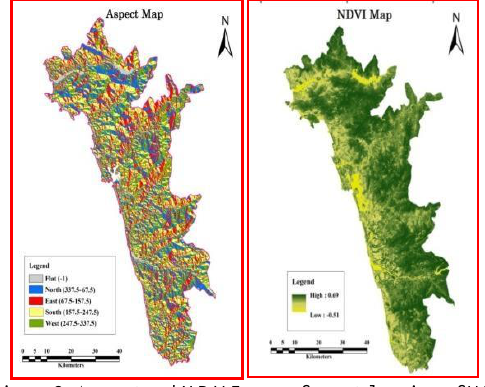
Figure 3. Aspect and NDVI map of coastal region of UK district The NDVI value for the land use classes with altitude is given in table 2. The NDVI indicating the range of value from - 0.51 to -0.27 for water body, -0.27 to 0.14 for open land, 0.14 to 0.37 for agriculture and 0.37 to 0.69 for the forest cover. The most of the healthy vegetation cover is found in the altitude from 70-750 m on the sloppy area of 20-86 degrees. The lower altitude area are more suitable for anthropogenic activities, hence most of the lower altitude places reduction in vegetation cover occurred as indicated by lower NDVI values (Koppad and Tikhile 2012). The increase in NDVI values with higheraltitude are due to non interference of the human/domestic animal activities. At the higher altitude beyond 625 m the NDVI values decreases due to steep slope at the tip of hill, erosion is one of the cause at steeper